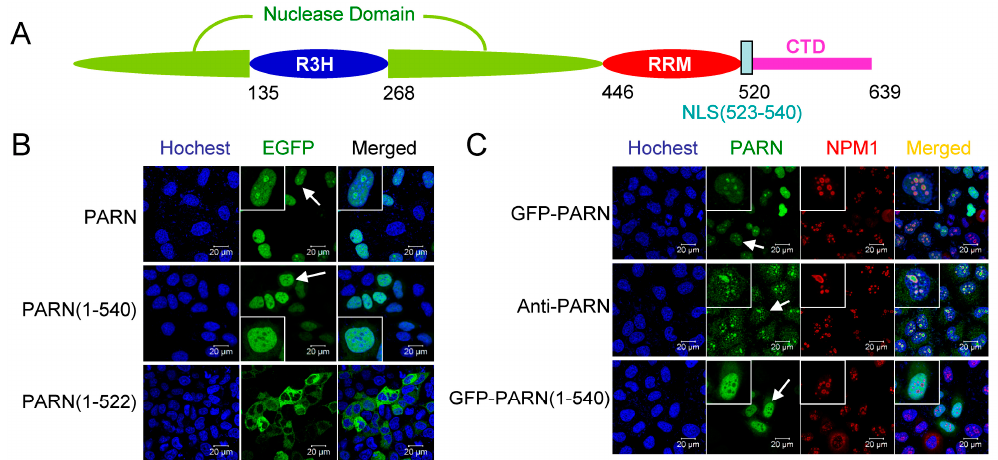
Figure 2. Identification of the nuclear localization sequence (NLS) in PARN . ( A ) A schematic model of domain compositions of human PARN. The position of the NLS is labeled. ( B ) Verification of the putative PARN-NLS(523–540) by confocal microscopy analysis of Chinese-hamster ovary (CHO) cells transiently transfected with plasmids containing EGFP-fused PARN and the two truncated forms. The represented images show the results of EGFP fused to the N-terminus of PARN, and similar results were obtained for EGFP fused to the C-terminus of PARN (data not shown). The nuclei were counterstained with Hoechst 33342. ( C ) PARN-NLS(523–540) directed the nucleoplasm but not nucleoli localization of PARN. The nucleoli were marked by nucleophosmin (NPM1) using mouse anti-NPM1 antibody (red). Endogenous PARN was immunostained by rabbit anti-PARN antibody (green). In panels B and C, the scale bars represent 20 µm and the insets show the magnified region indicated by the arrows. (green). In panels B and C, the scale bars represent 20 µ m and the insets show the magnified region indicated by the